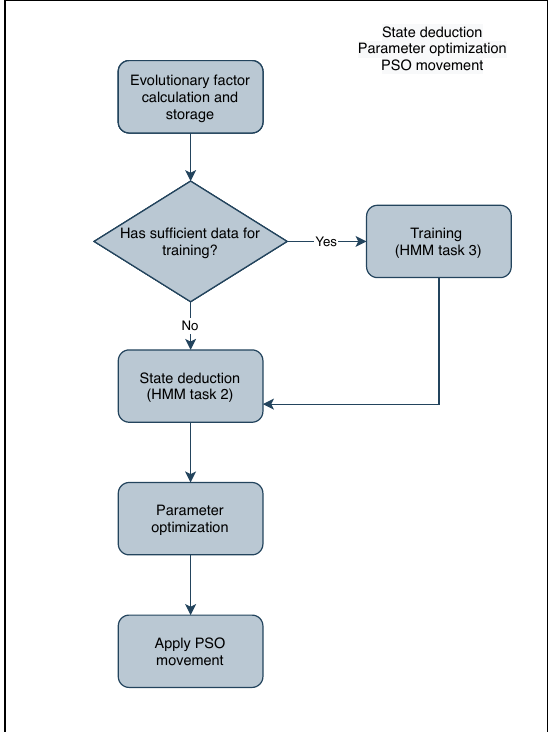
Figure 6. State deduction and parameter adjustment for